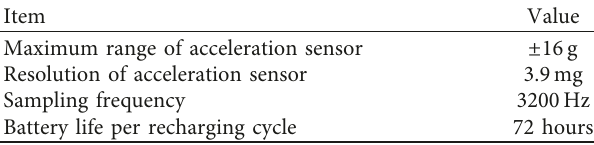
Table 2: Main parameters of the VMWD system.